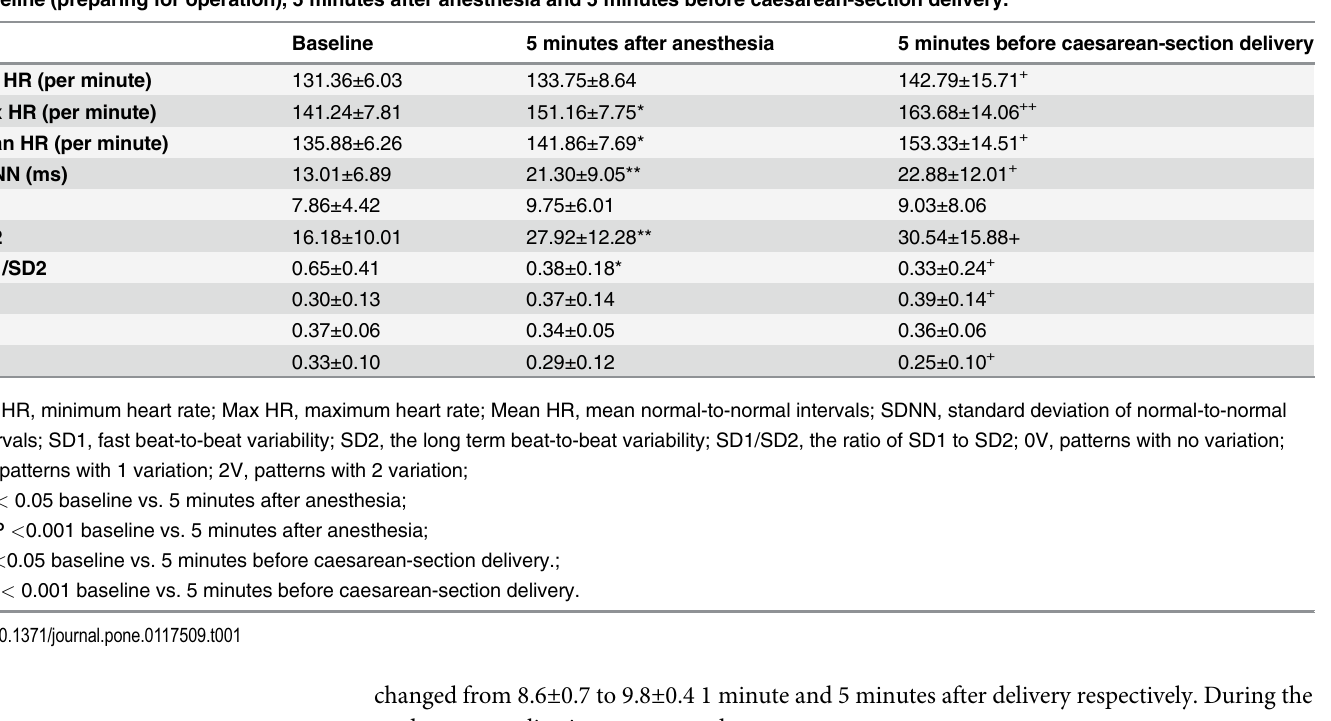
Table 1. The mean minimum FHR 5 minutes after anesthesia was similar to the baseline FHR (133.75±8.64 vs. 131.36±6.03 per minute, P > 0.05) but increased significantly before delivery